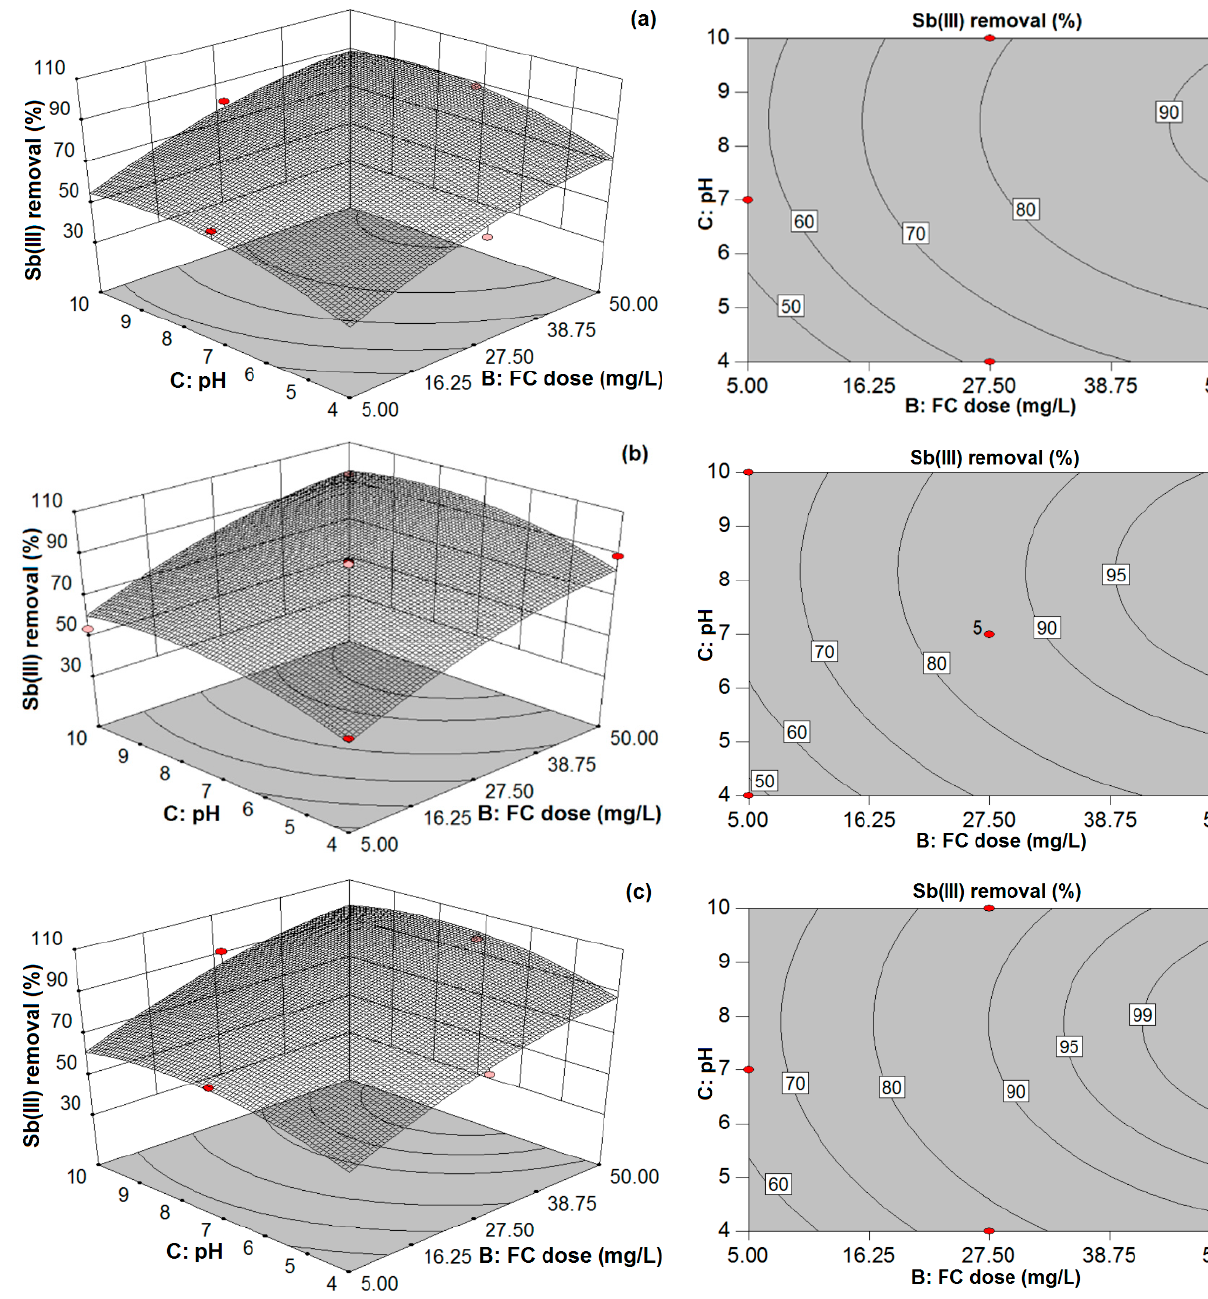
Figure 1. Three-dimensional surface plots and corresponding contour plots showing Sb(III) removal under various pHs (4–10) and FC doses (5–50 mg/L) for an Sb(III) concentration of ( a , d ) 100 µg/L; ( b , e ) 550 µg/L; ( c , f ) 1000 µg/L.